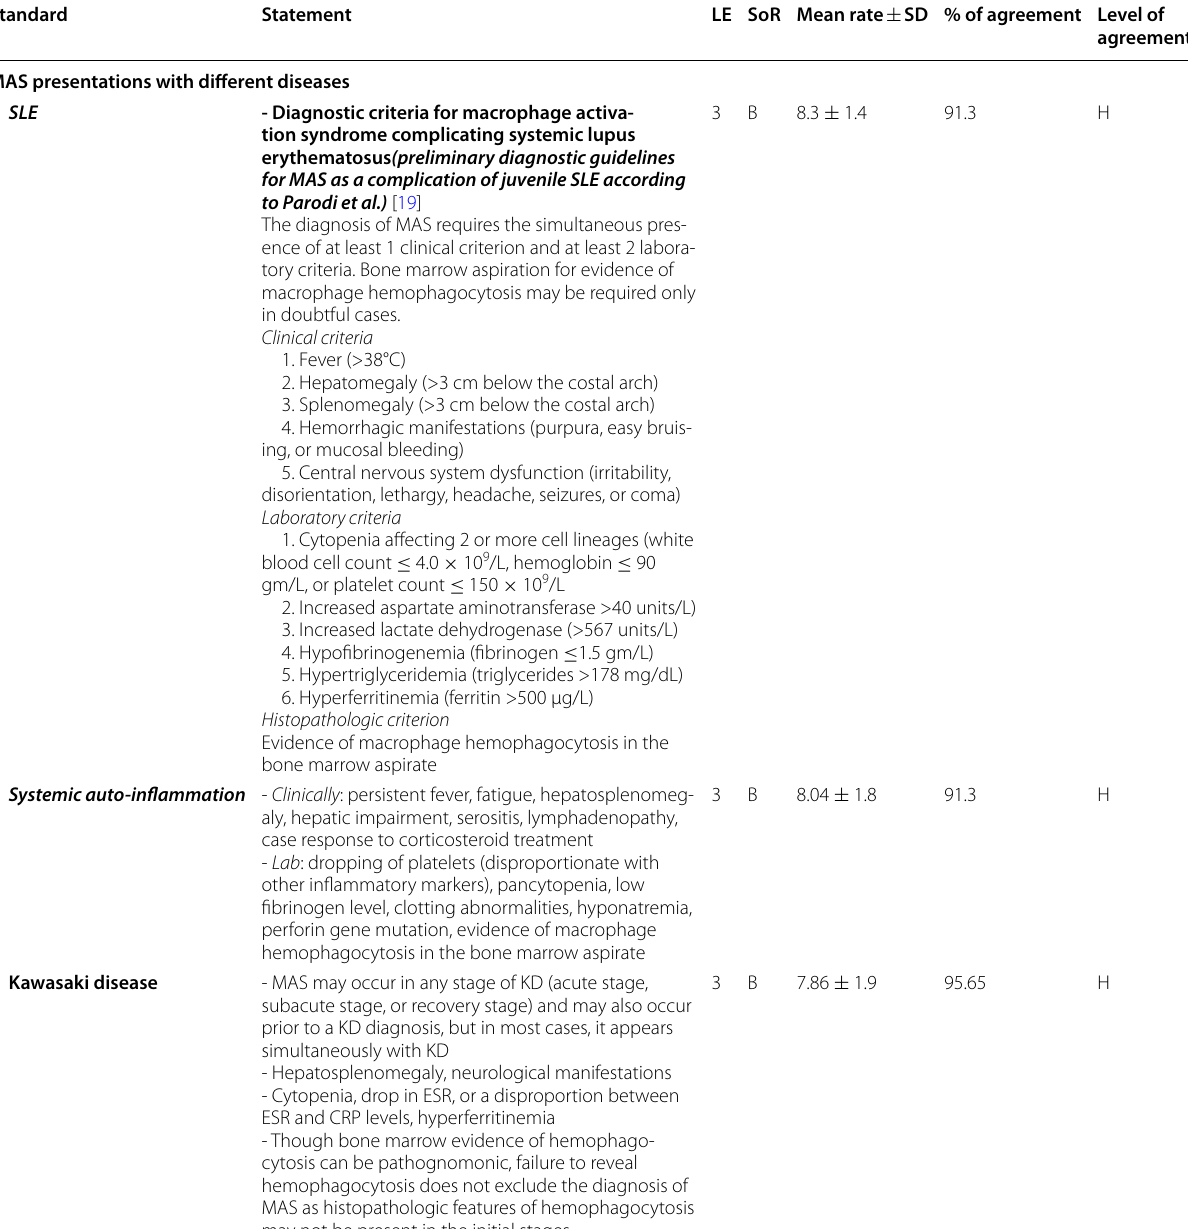
SD % of agreement Level of ± agreement